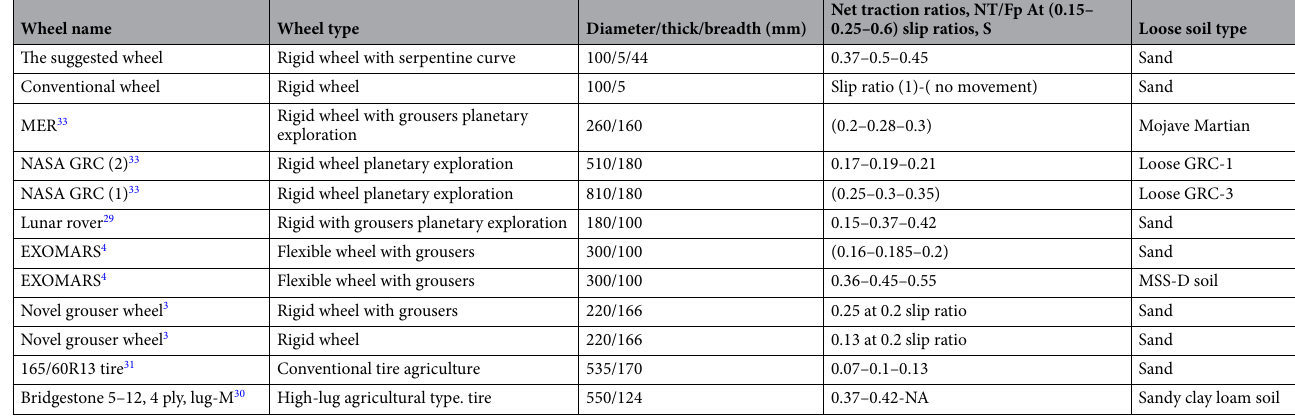
Table 3. The net traction ratios